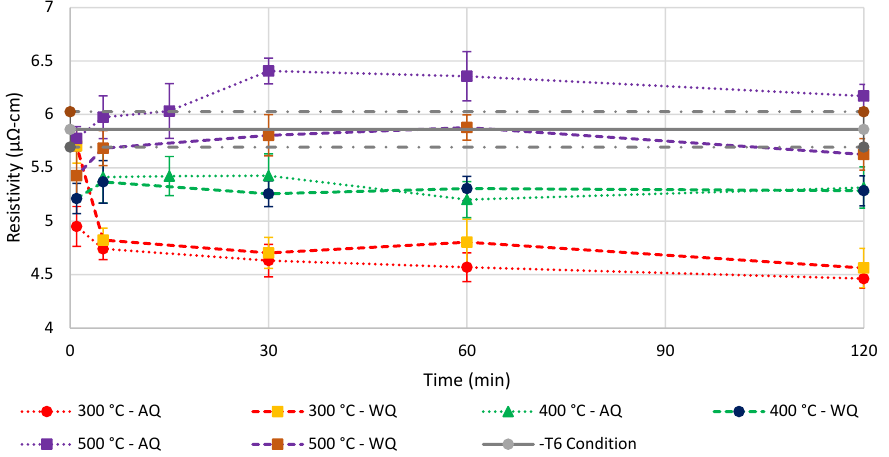
Figure 7. Resulting resistivity of different heat treatment cycles; Legend values indicate furnace temperature; AQ—air quenched, WQ—water